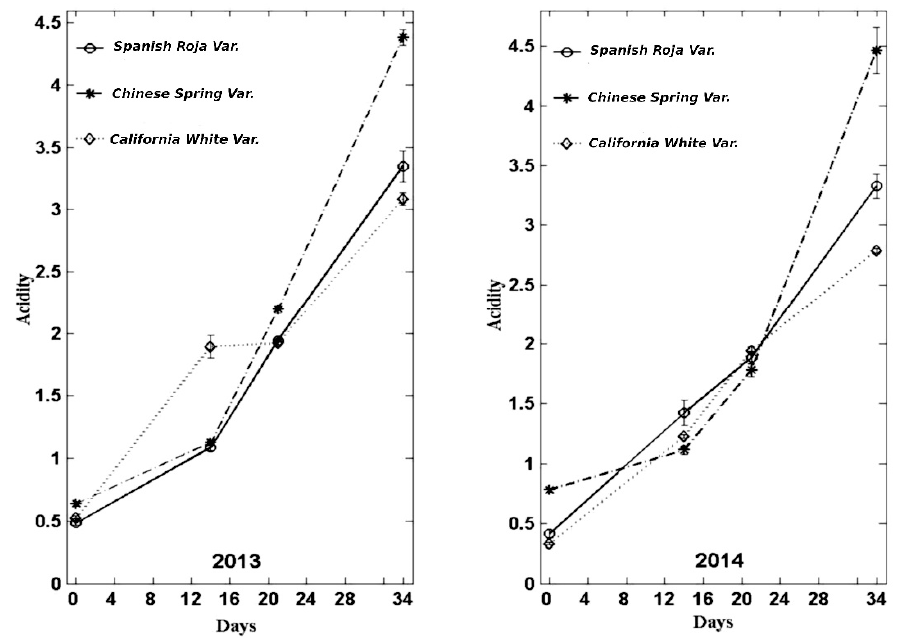
Figure 1. Evolution of acidity (% citric acid) during the manufacture of black garlic with three varieties and two types of garlic: one-year old garlic (2013) and garlic recently harvested (right).